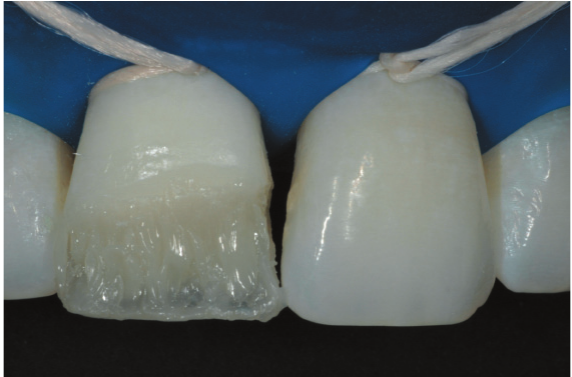
Figure 4- Artificial palatal enamel made using a silicon personalized guide